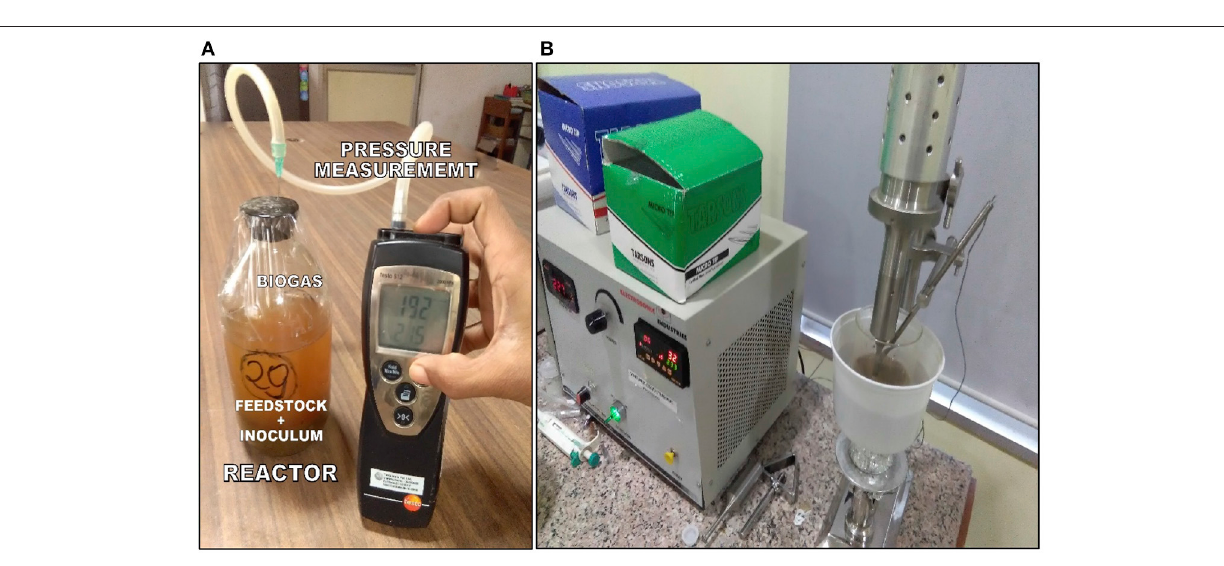
showed 57% lower methane in comparison with the thermophilic straw and manure get increased up to 22.4% by means of mixing another substrate i.e., fruit and vegetable waste (Wang et